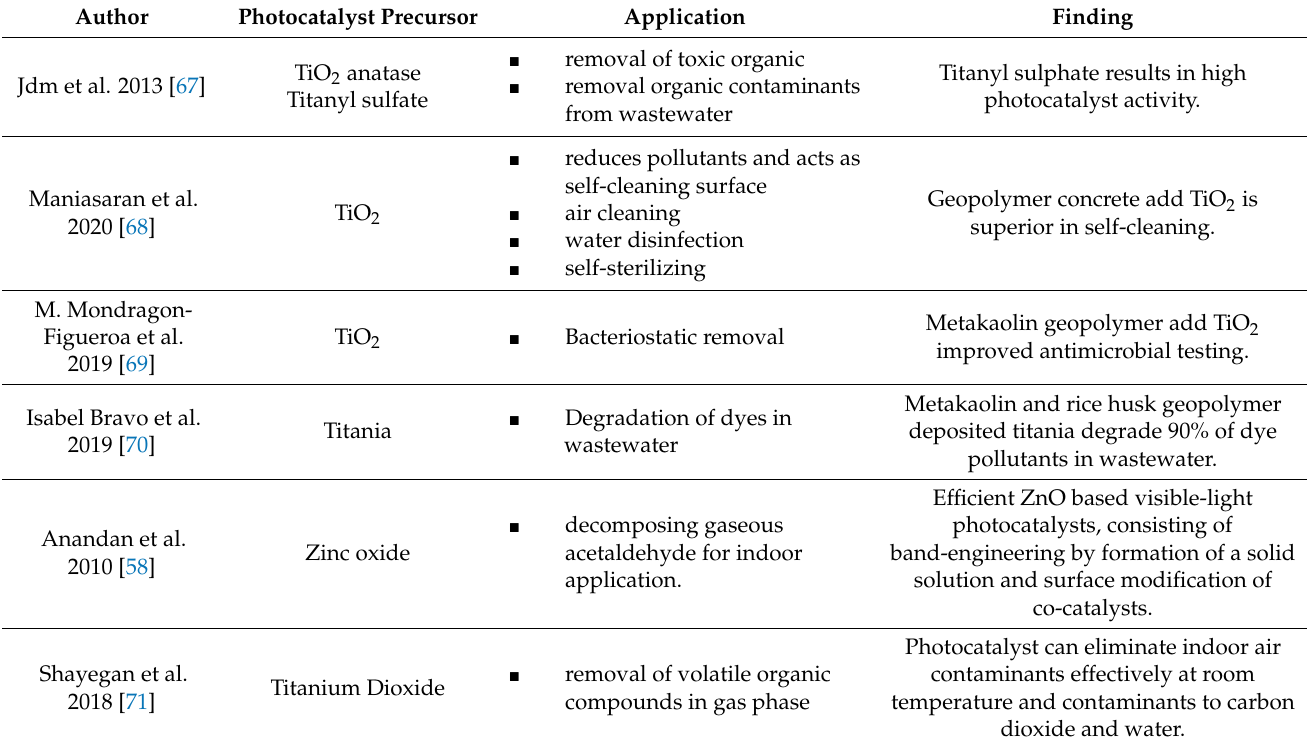
Table 2. Summary of photocatalyst technology